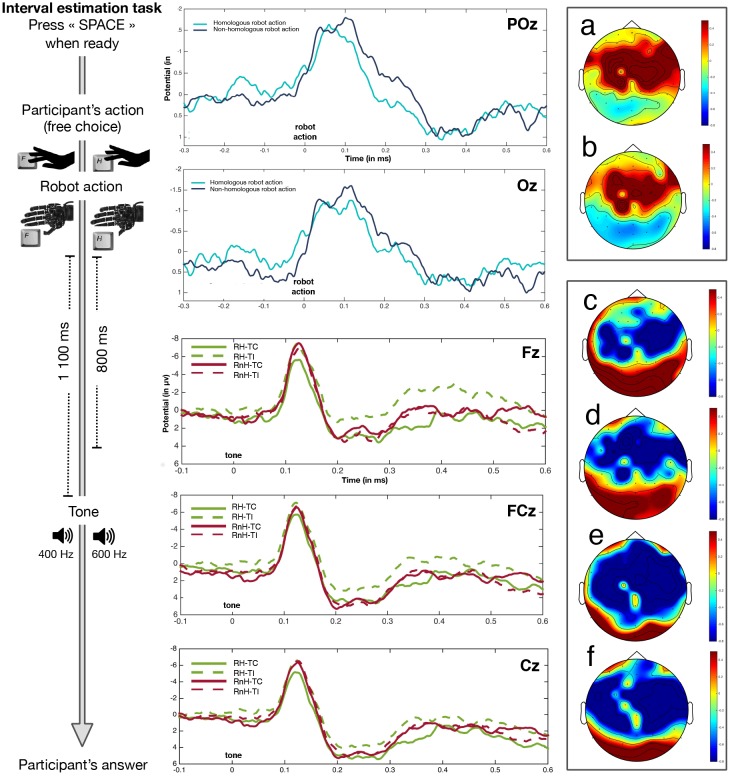
Electrophysiological results.On POz and Oz, the light blue displays the visual N1 associated with a homologous robot movement, while the dark blue displays the visual N1 associated with a non-homologous robot movement. On Fz, FCz and Cz, the full green line displays brain potentials associated with the robot homologous—tone congruent condition (RH–TC), the dotted green line displays brain potentials associated with the robot homologous—tone incongruent condition (RH-TI), the full red line displays brain potentials associated with the robot non-homologous—tone congruent condition (RnH-TC), and the dotted red line displays brain potentials associated with the robot non-homologous—tone incongruent condition (RnH-TI). (A) Topographical representation associated with homologous robot movement. (B) Topographical representation associated with non-homologous robot movement. (C) Topographical representation associated with RH-TC. (D) Topographical representation associated with RH-TI. (E) Topographical representation associated with RnH-TC. (F) Topographical representation associated with RnH-TI.